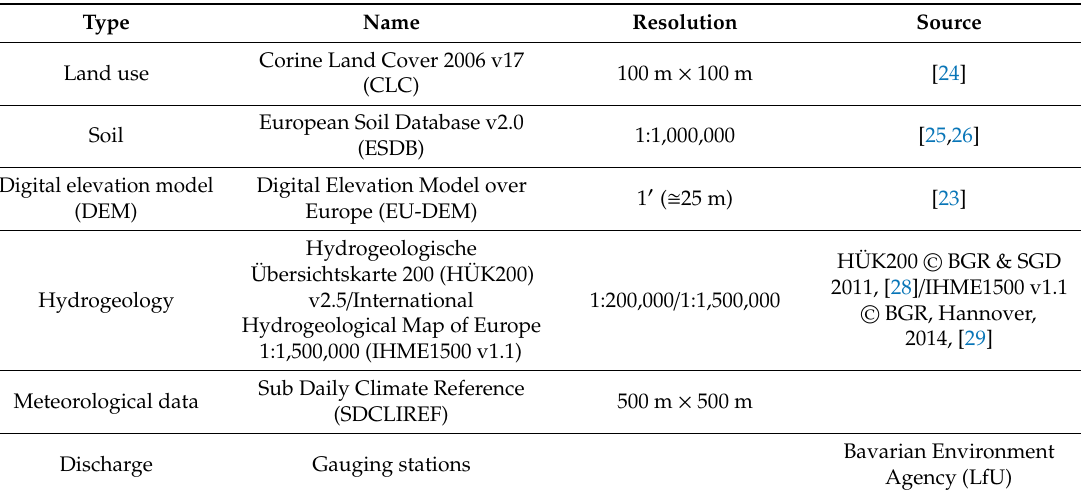
Table 1. Input and validation data for the hydrological